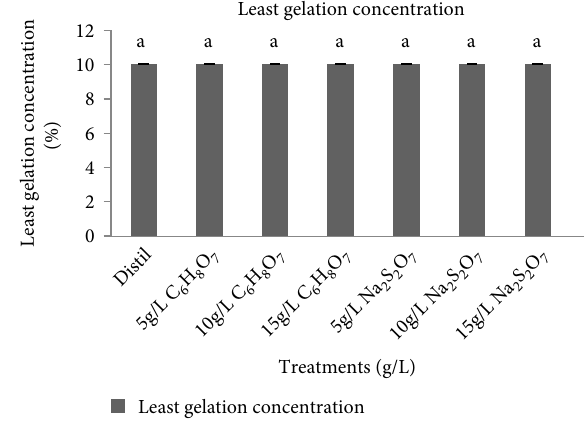
H O = citric acid and Na 6 8 7